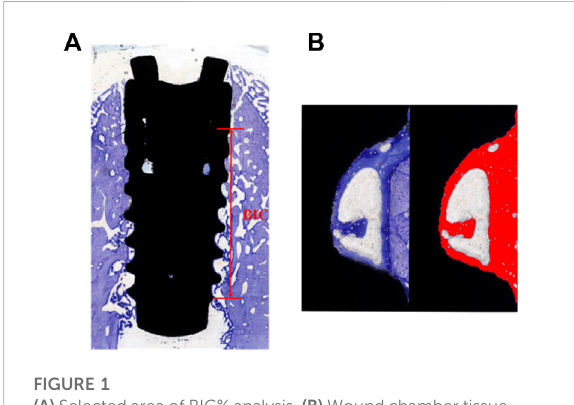
FIGURE 1 (A) Selected area of BIC% analysis. (B) Wound chamber tissue area